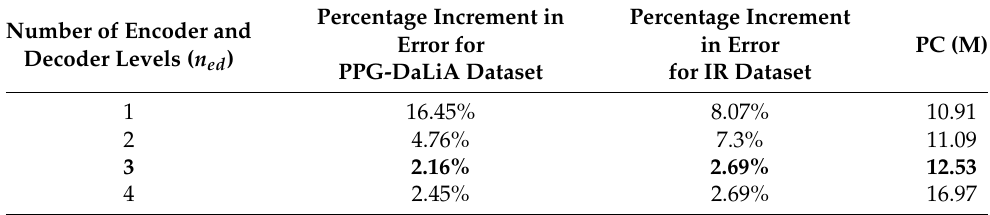
Table 5. Comparison among the student model designed with various level of encoder and decoder. Number of Encoder